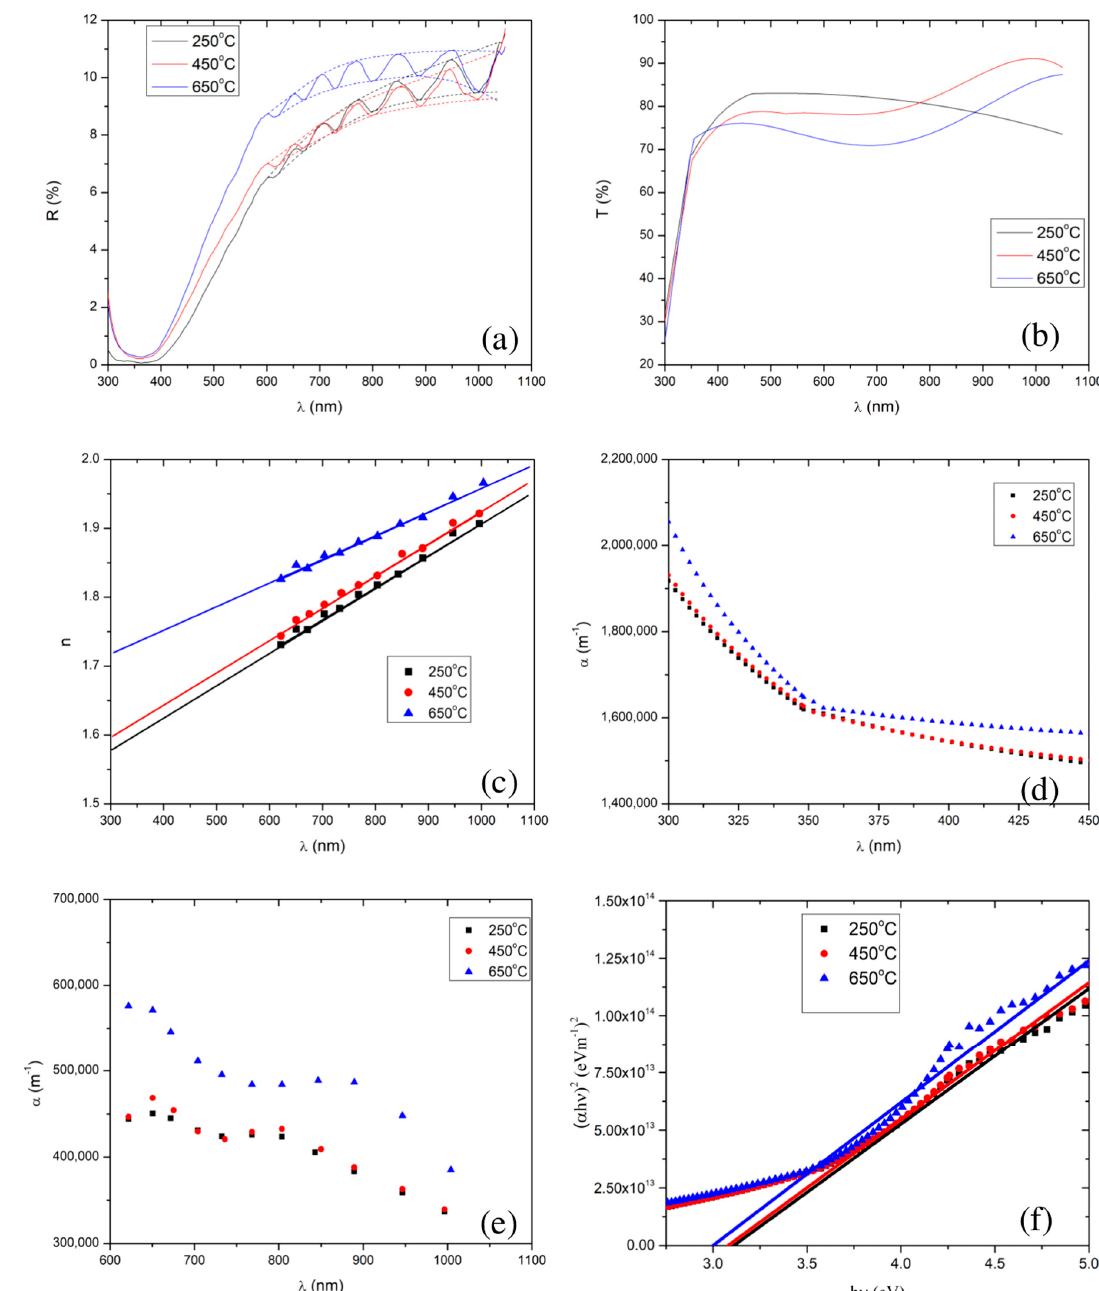
Figure 4. Plots ( a ) and ( b ) show the reflectance and transmittance spectra, respectively, of the SnO 2 thin films calcined at 250 ◦ C, 450 ◦ C, and 650 ◦ C. Plots ( c ) and ( d ) show the refractive index and absorption coefficient, respectively, as a function of wavelength, which are extracted from the reflectance spectra. Plots ( e ) and ( f ) show the absorption coefficient and Tauc plot, respectively, which are extracted from the transmittance spectra. Note that in ( a ), the reflection spectra are denoted by solid lines, and the upper and lower limits of an envelope of each reflectance curve are denoted by the dotted lines.